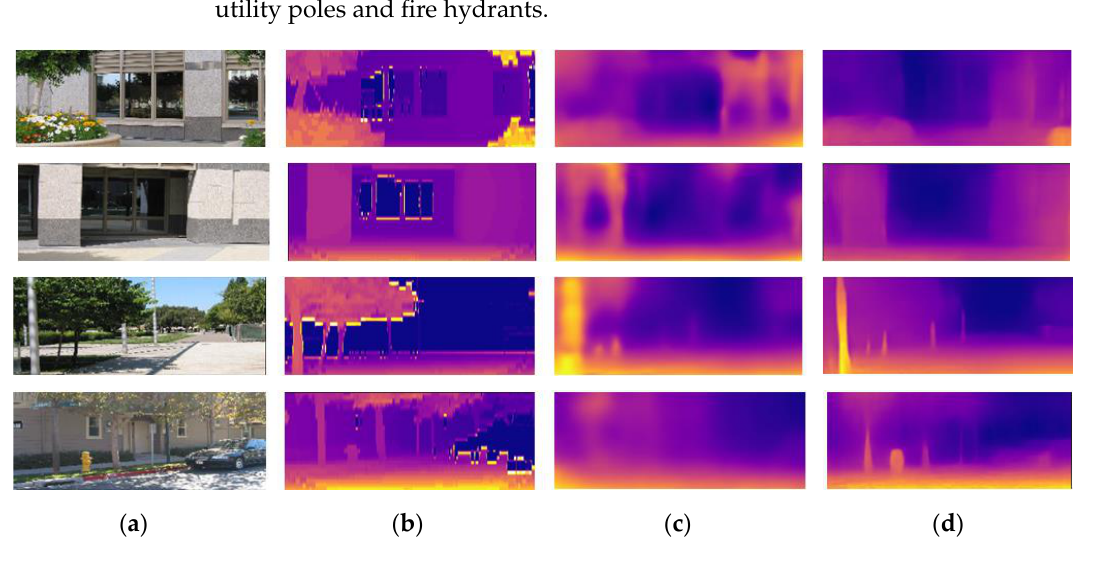
Figure 13. Qualitative results of our approach on the Make3D dataset. Note that our proposed method and the method proposed by Zhou et al. [43] are only trained on the KITTI dataset. ( a ) input images; ( b ) ground truth depth images; ( c ) result in [43]; ( d ) our approach.